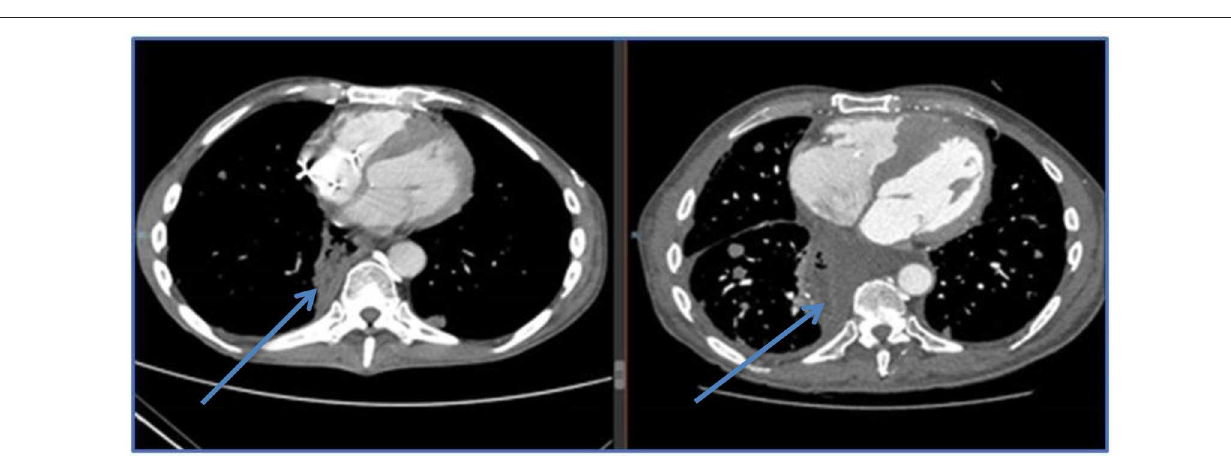
Frontiers in Endocrinology |